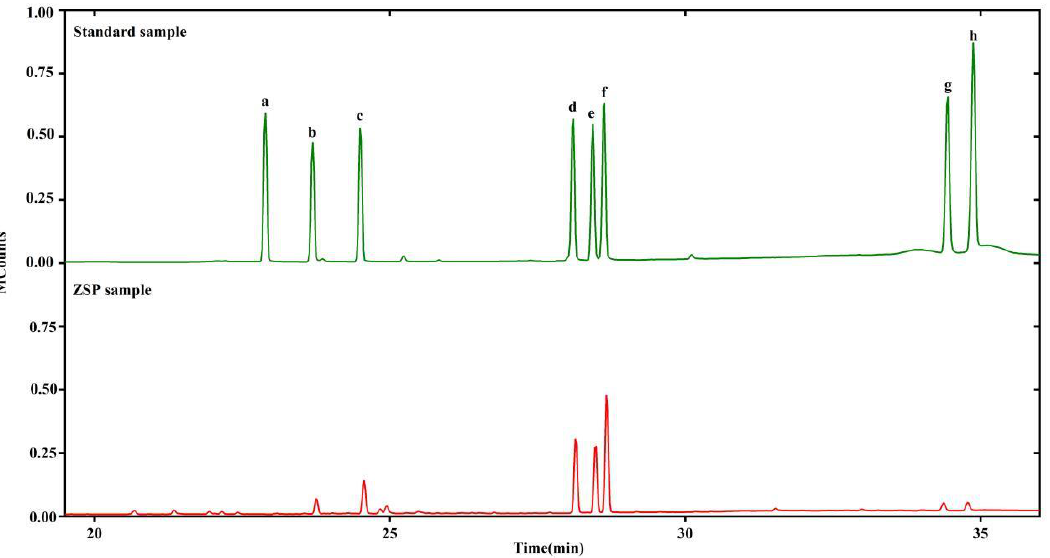
Figure 2. Standard monosaccharides: ( a ) D-rhamnose, ( b ) D-arabinose, ( c ) D-xylose, ( d ) D-mannose, ( e ) glucose, ( f ) D-galactose, ( g ) D-galacturonic acid, ( h ) D-glucuronic acid (Above); GC-MS profile of ZSP peaks (Below).